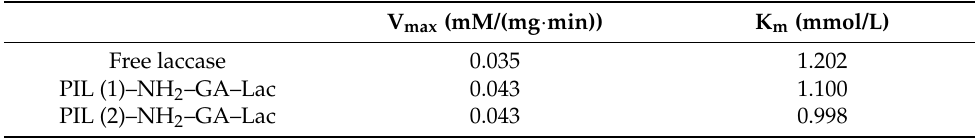
Table 1. K m and V max of free laccase and immobilized